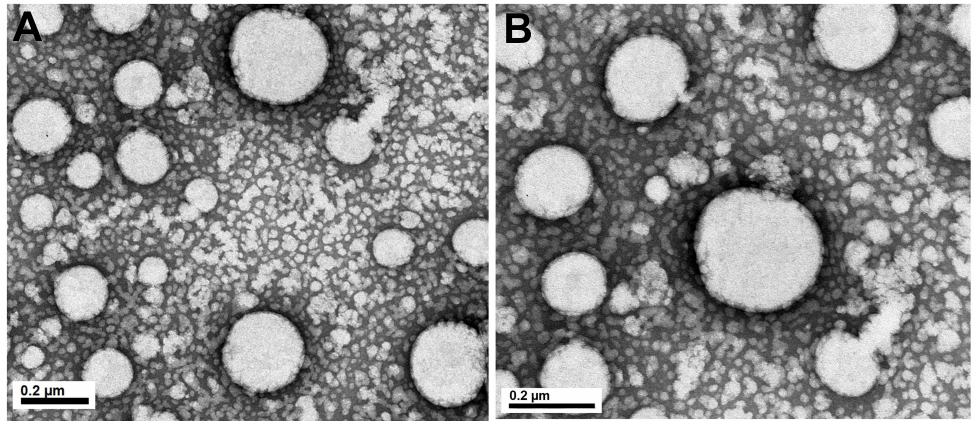
Figure 1. TEM images of nanoemulsion containing A. satureioides extract (NE ASE ). Where: ( A ) 75 K increase and ( B ) 120 K